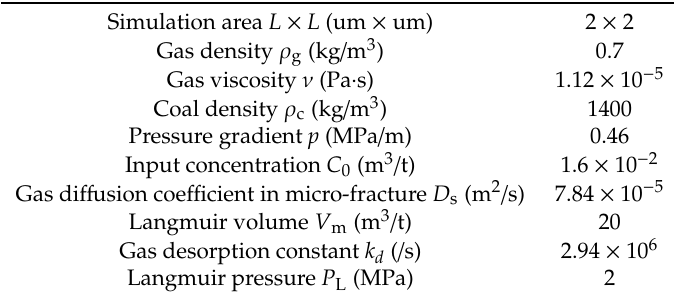
Table 1. The input parameters in the simulation.